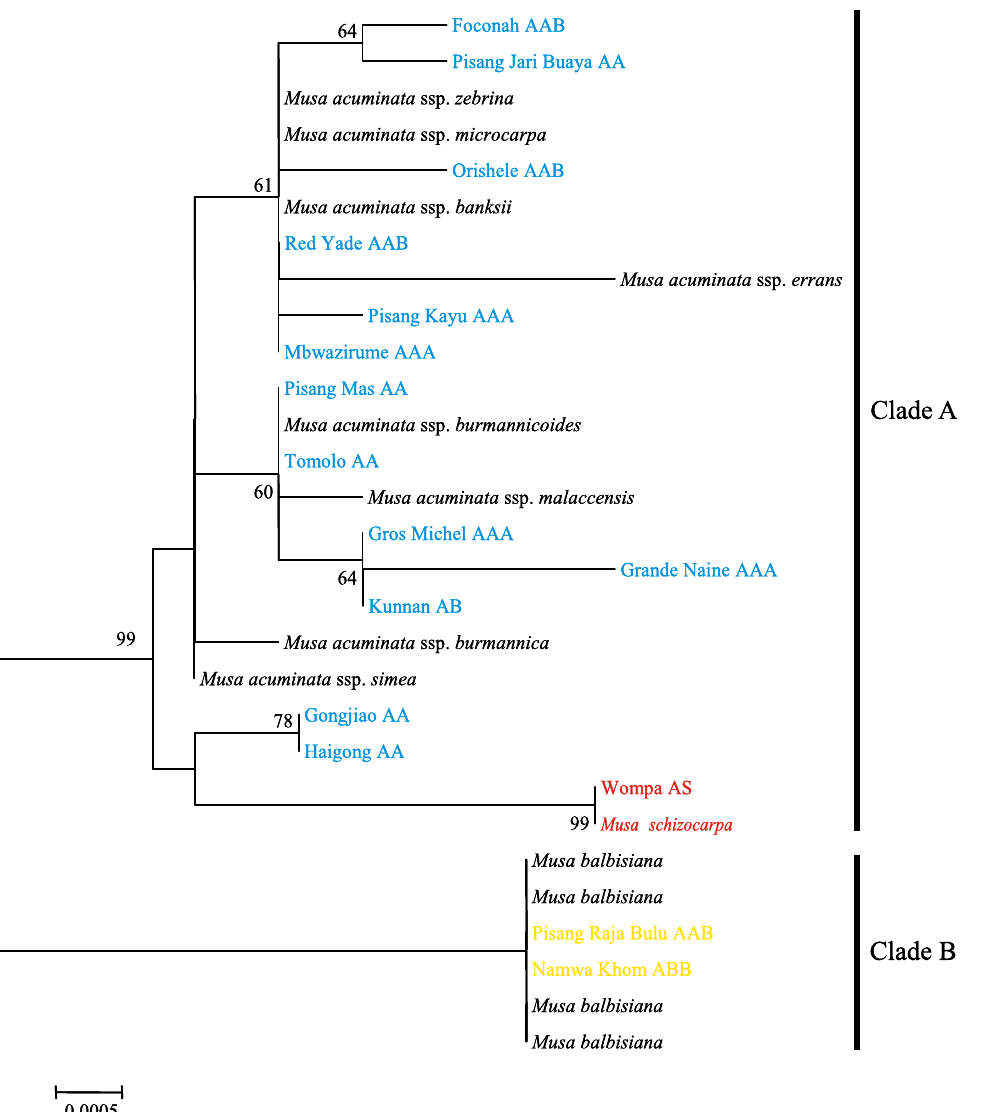
Figure 3. Neighbor-joining (NJ) tre e inferred from the concatenated chloroplast ( matK and trnL-F ) fragments of Musa accessions. Numbers near branches are bootstrap percentages and branches without numbers indicate values lower than 50%. Capital letters following each accession name indicate the previously-recognized genome composition of the cultivar. Color-coded names of accessions indicate the A (blue), S (red) and B (yellow) genomes of cultivated bananas and their wild relatives M. acuminata (black), M. schizocarpa (red) and M. balbisiana (black).